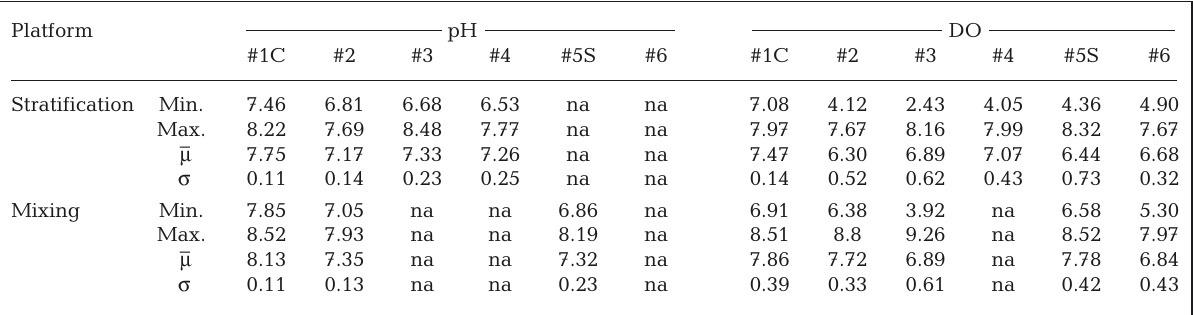
Table 1. Minimum, maximum, mean (– μ ), and standard deviation ( σ ) of pH and dissolved oxygen (DO) values of time series in Fig. 4. na: not